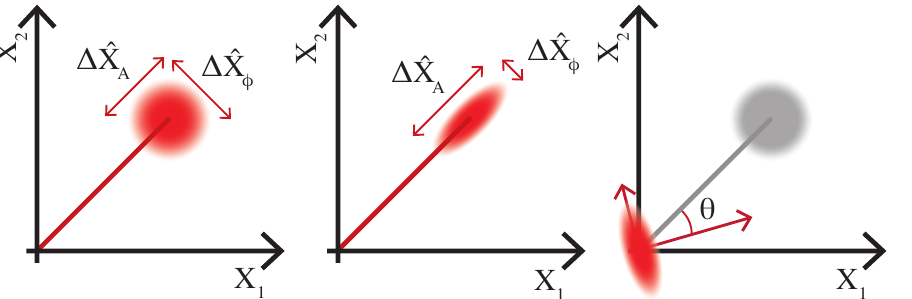
Figure 2. Ball-and-stick diagrams for a coherent state of light ( left ), a squeezed state of light ( center ), and squeezed vacuum ( right ). The red line is a phasor: the amplitude of the state is represented by the length of the line, while the phase is represented by the angle of the line relative to the two quadrature axes—X 1 and X 2 . The uncertainty of the state is represented by a fuzzy ball at the end of the stick. The squeezed vacuum field is oriented with angle θ to the quadrature